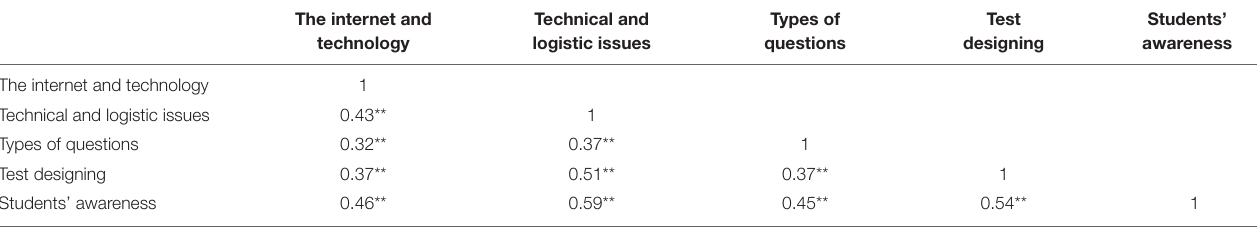
TABLE 2 | Results of Pearson